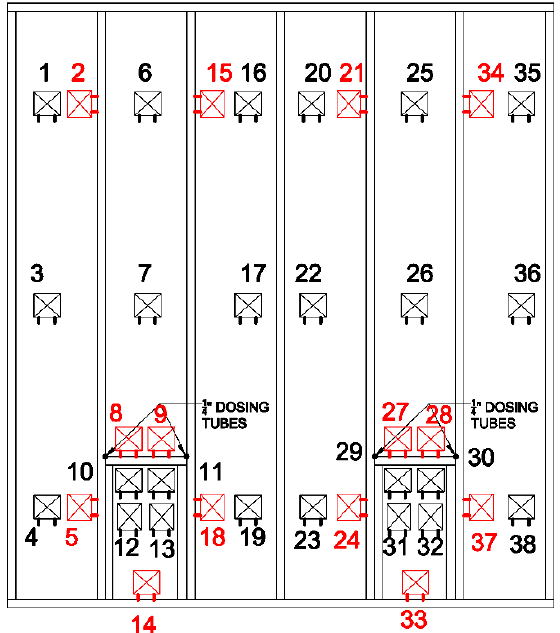
Figure 5. Typical sensor layout for 2.4 m (8 ft) wide by 2.7 m (9 ft) high wall